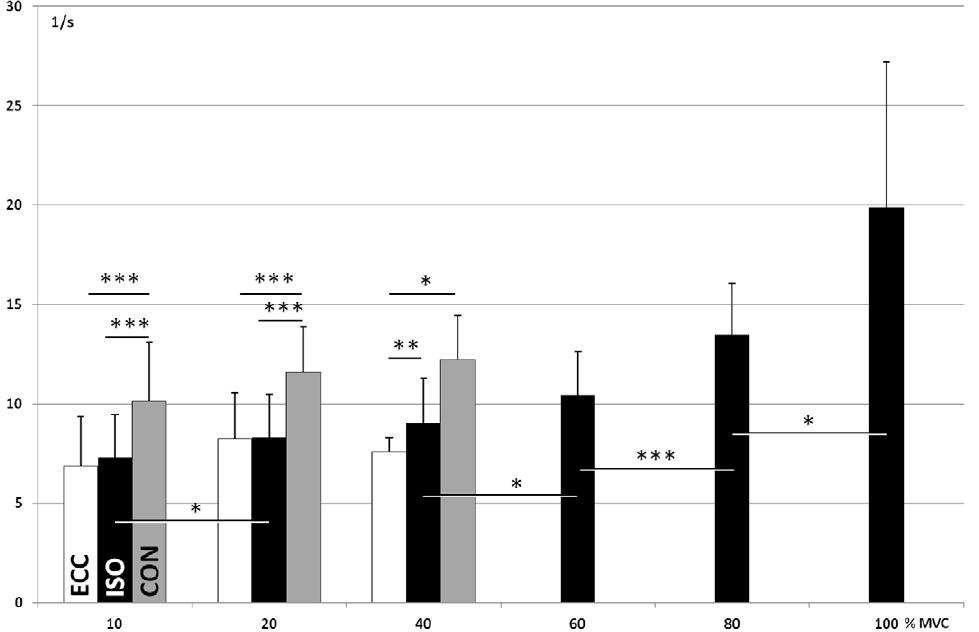
Figure 2. Motor unit discharge rate (1/s; X ± SD) at different relative force levels (%MVC) in eccentric (ECC), isometric (ISO) and concentric (CON) contractions. Significant differences between conditions and force-levels: * =p , .05, ** =p , .01, *** =p , .001. doi:10.1371/journal.pone.0053425.g002 PLOS ONE |